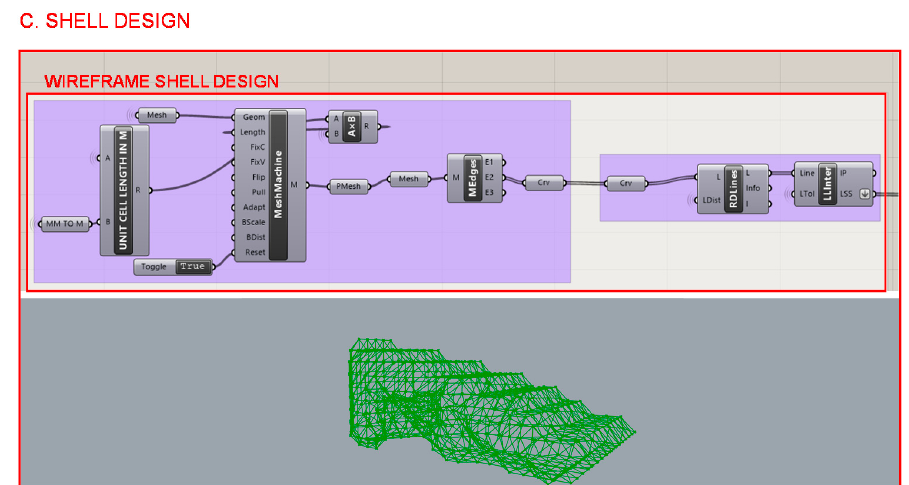
Figure 23. Programming structure definition of the shell design and its visualization in the Rhinoceros interface.